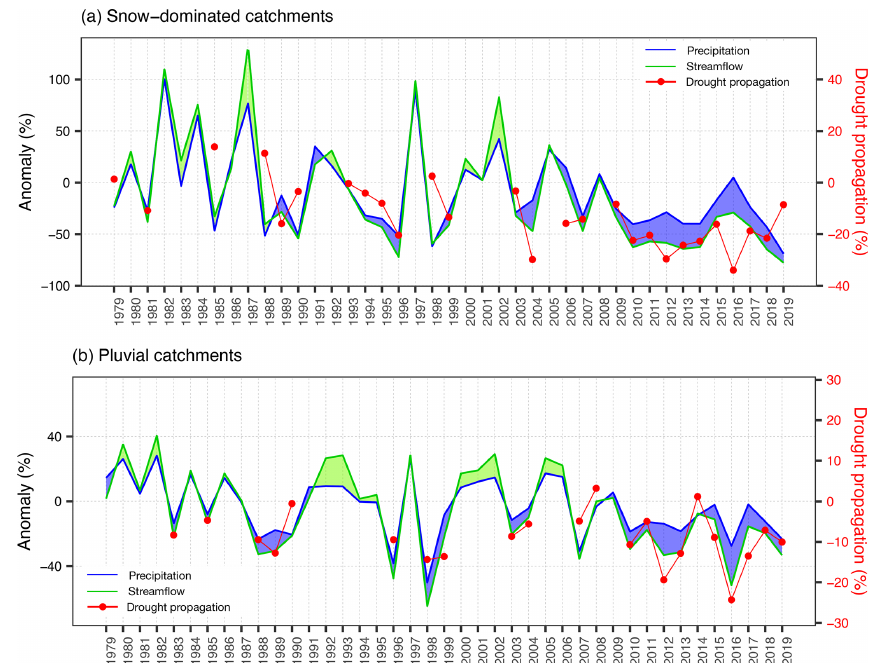
Figure 8. Precipitation and runoff anomalies in snow-dominated (a) and pluvial catchments (b) . The blue shaded area between curves represents precipitation anomalies larger than streamflow anomalies, and the green shaded area represents the opposite. The meteorological to hydrological drought propagation, represented by the difference between runoff and precipitation anomalies for those years where runoff anomaly is below zero, is shown on the secondary y axis by red points connected with red lines between consecutive